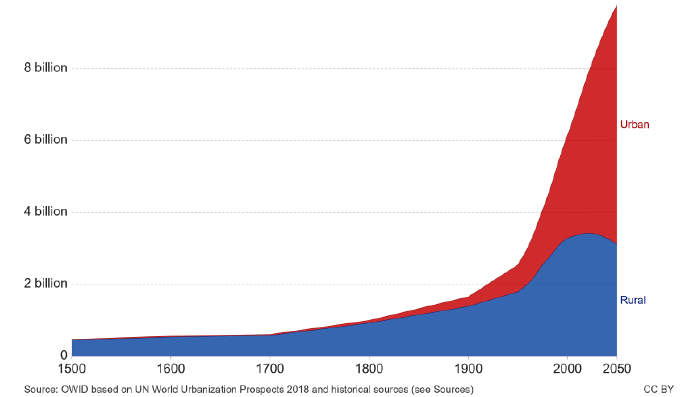
Figure 1. Urban and rural population projected to 2050 [41].